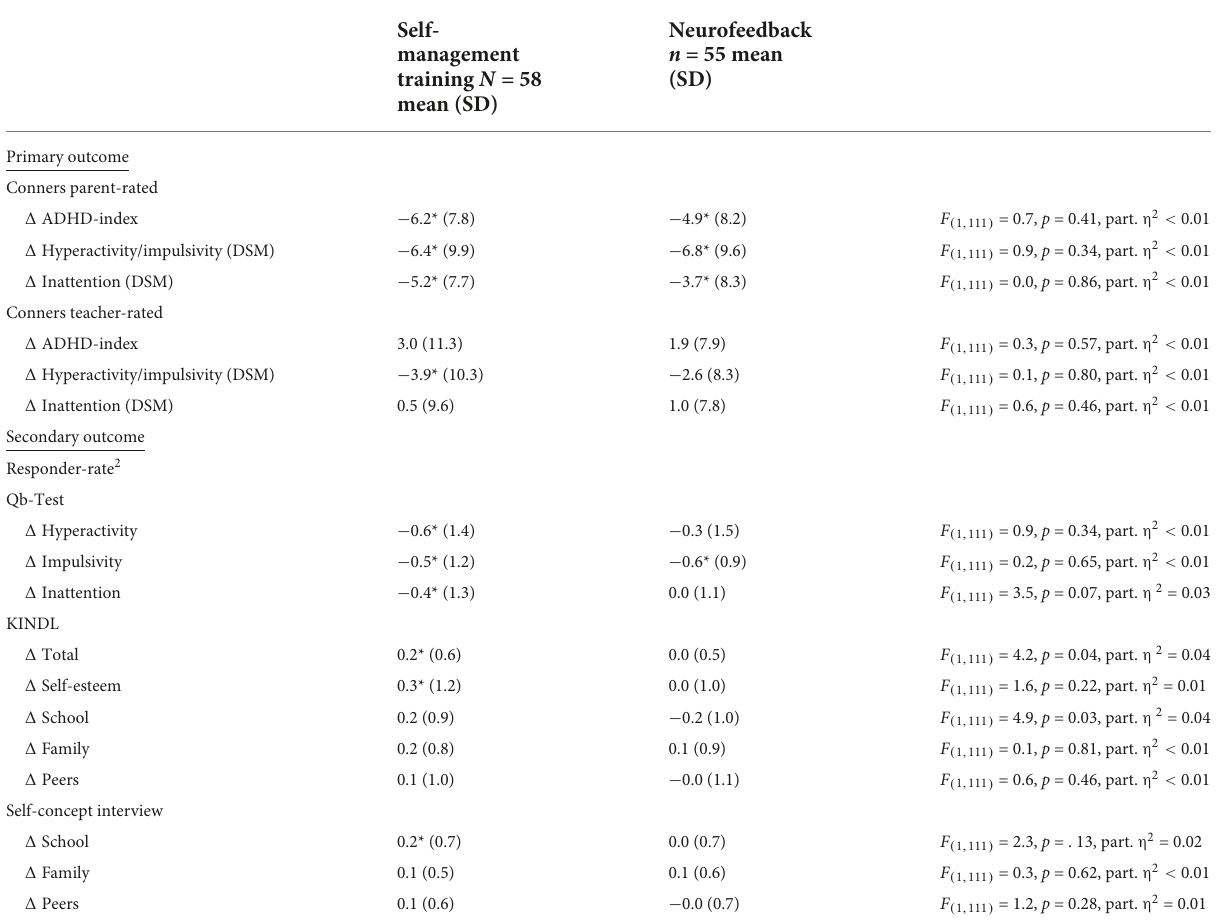
TABLE 2 Change in main outcome criteria from baseline (T1) to post-treatment (T3, mITT).